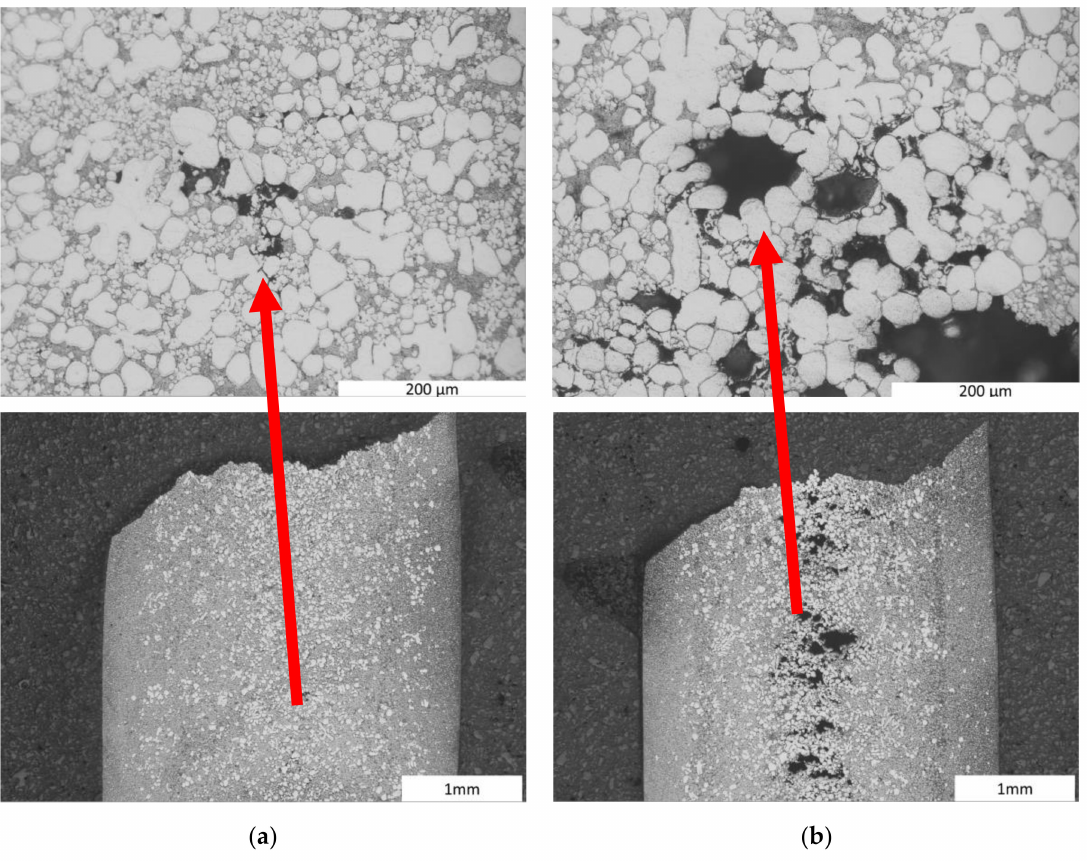
Figure 2. Illustration of the overall microstructures, in a longitudinal cross-section along the central axial plane of the tensile sample after tensile testing, obtained for the cast Magsimal 59 alloy and the specific feature of interest using: ( a ) Intensified shearing; and ( b ) Standard RheoMetal TM